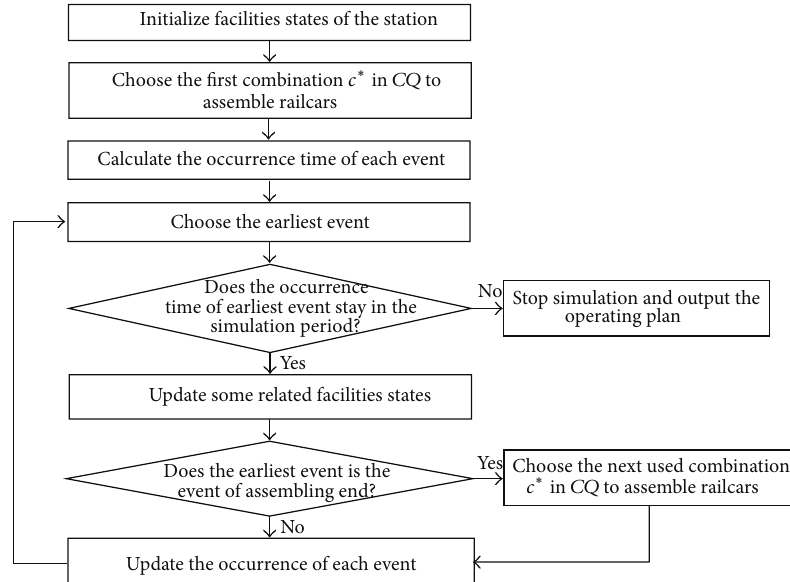
Figure 5: The simulation framework of operating